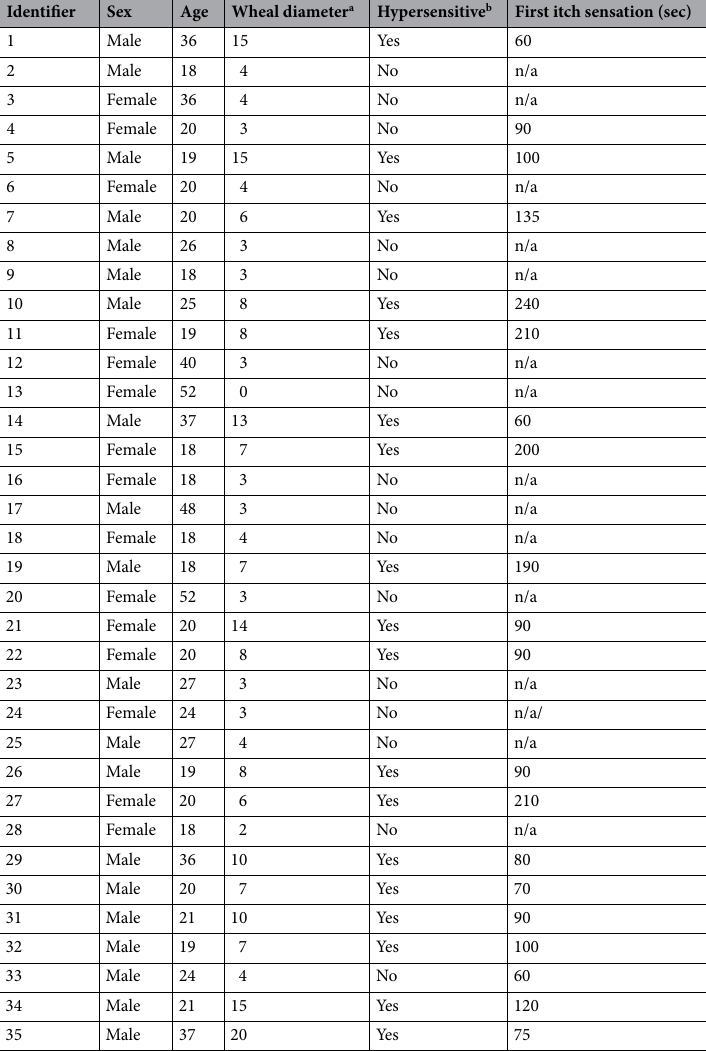
Table 1. Subject characteristics. a Largest wheal diameter per subject in mm. b Hypersensitive was defined as any subject with a wheal > 5 mm in